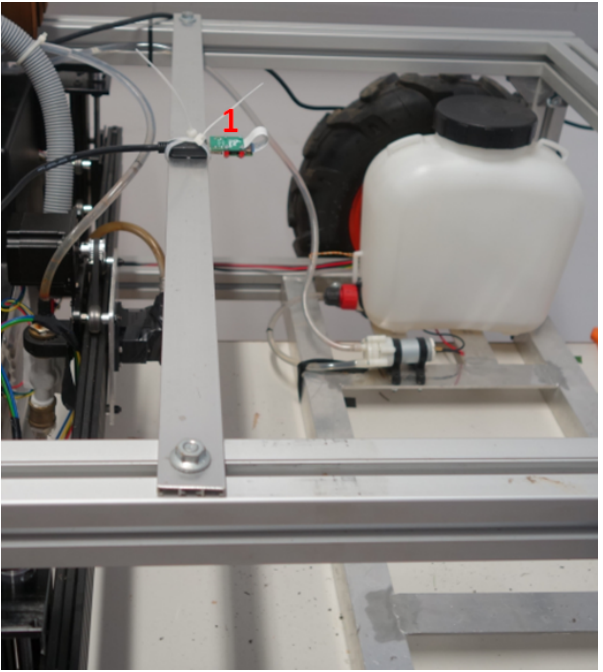
Figure 7. Camera location (1) embedded on the robotic orchard